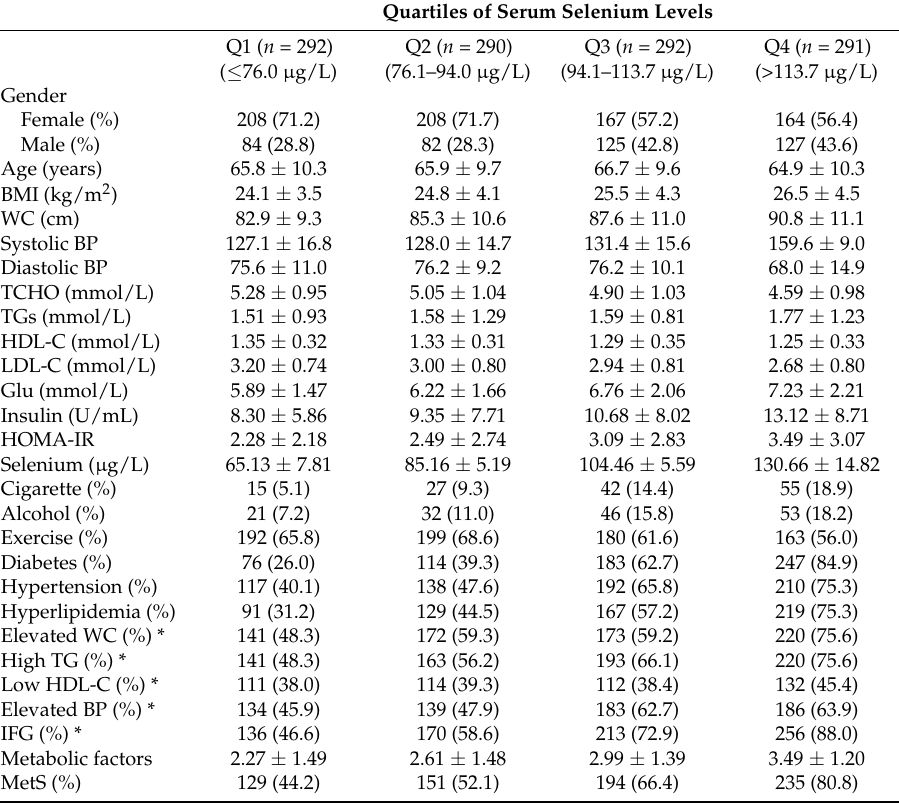
Table 1. Characteristics of the study population by quartiles of serum selenium levels.